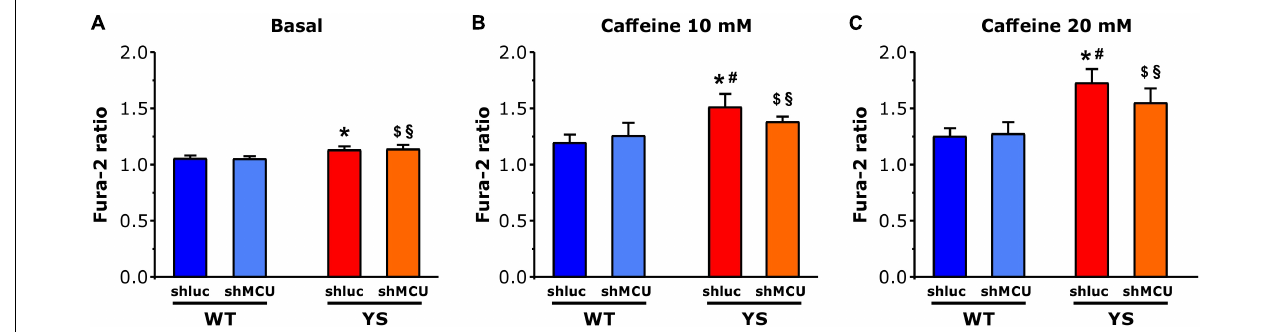
FIGURE 5 | Cytosolic free Ca 2 + concentrations determined as Fura-2 ratio following silencing of MCU. (A–C) Basal resting Ca 2 + levels as evaluated by Fura 2 ratio during low frequency stimulation at 0.5 Hz is higher in YS fibers than in WT in the absence of caffeine (A) and in the presence of 10 mM caffeine (B) or 20 mM caffeine (C) . The increase of cytosolic calcium in YS fibers in response to 10 and 20 mM caffeine is reduced by silencing MCU. Four groups of fibers are compared: WT fibers transfected with shMCU (silencing), WT fibers transfected with shluc (control transfection), YS fibers transfected with shMCU (silencing), and YS fibers transfected with shluc (control transfection). Data are shown as means ± SEM; p < 0.05: ∗ YS shluc vs. WT shluc and WT shMCU; $ YS shMCU vs. WT shluc; § YS shMCU vs. WT shluc; and # YS shluc vs. YS shMCU.